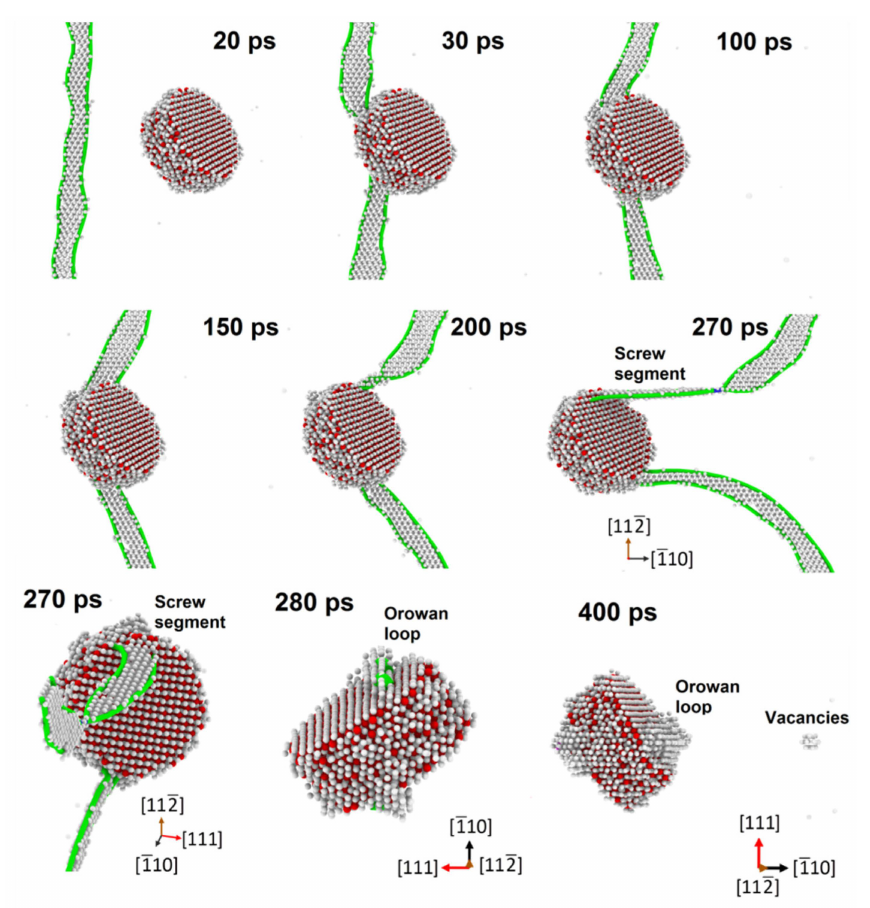
Figure 5. The first dislocation–precipitate interaction. Atoms with a centrosymmetry parameter more than 5 square angstroms are depicted. Aluminum atoms are colored in gray, copper atoms are red. Shockley partial dislocations are colored in